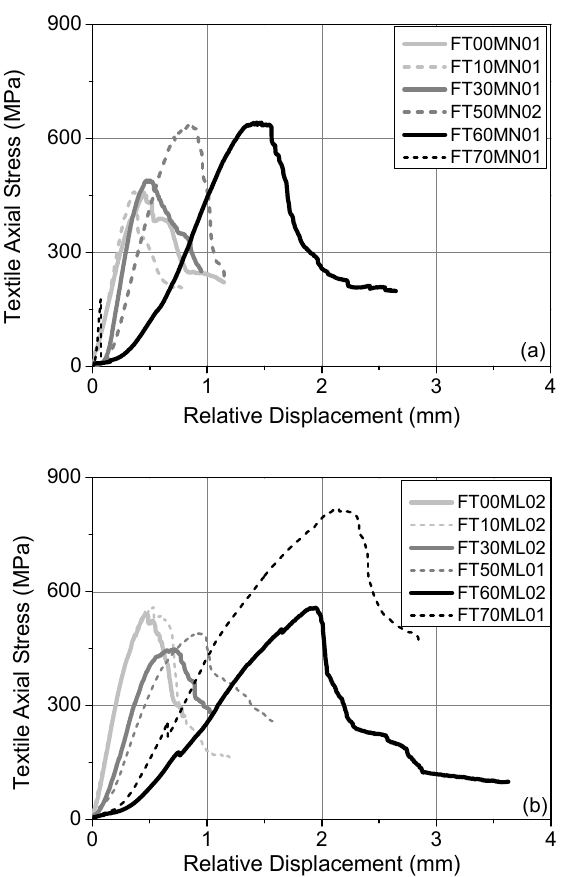
Figure 8. Response curves ( σ vs. d r ) of representative specimens furnished with ( a ) TRNM and ( b ) TRLM overlays.